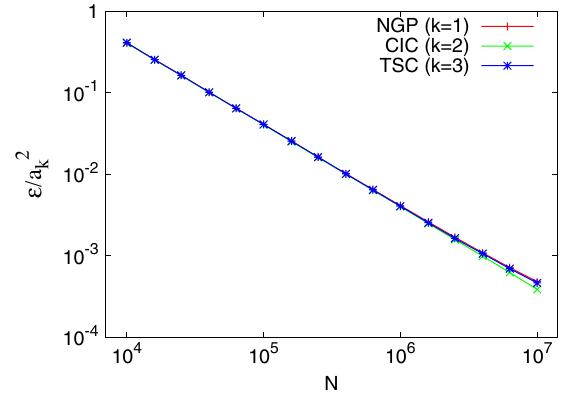
FIG. 2. Accuracy [measured by the IMSE given in Eq. (20)], of the deposition scheme, versus the number of scaled to a 2 k particles N for the three lowest-order CDS: NGP (red line), CIC (green), and TSC (blue) for the 2D sinusoidally modulated flattop distribution used in Sec.